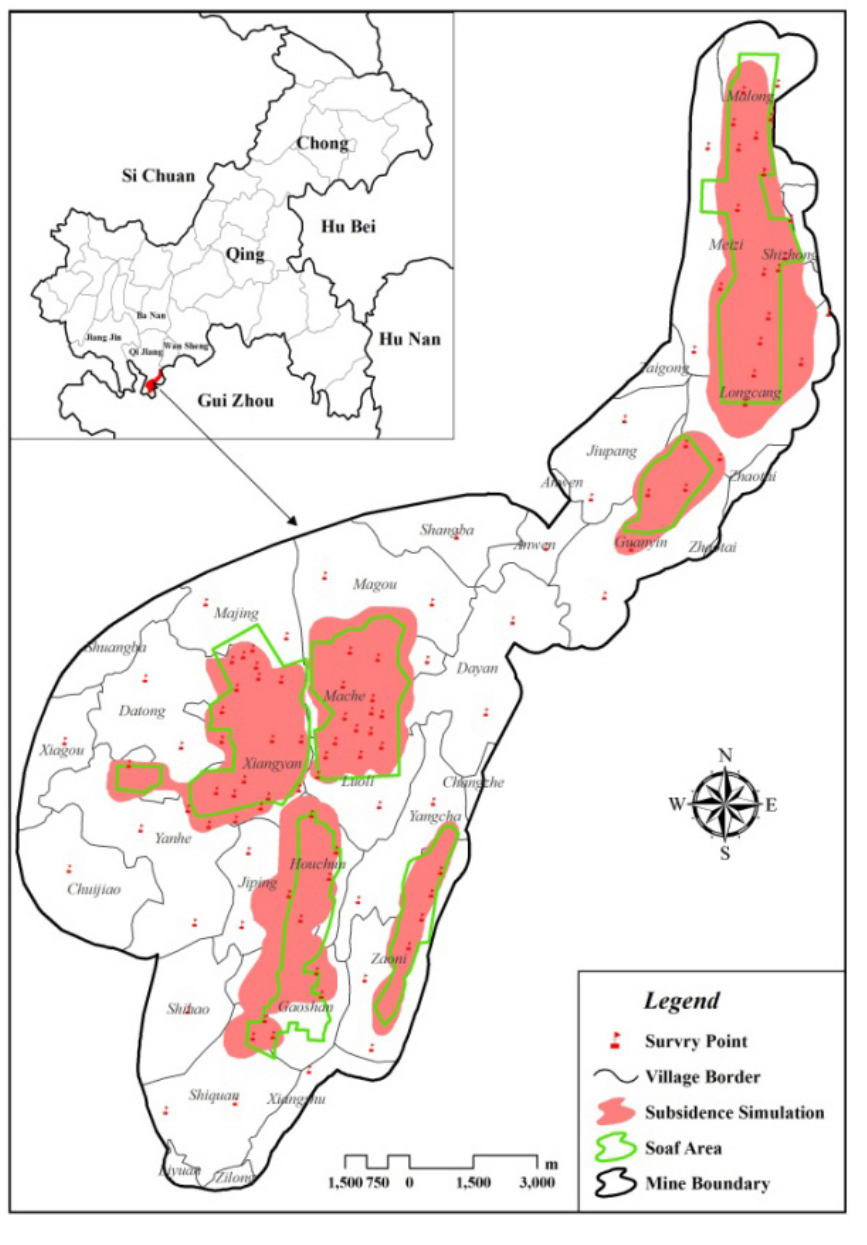
Figure 1. Location and overlay analysis map.